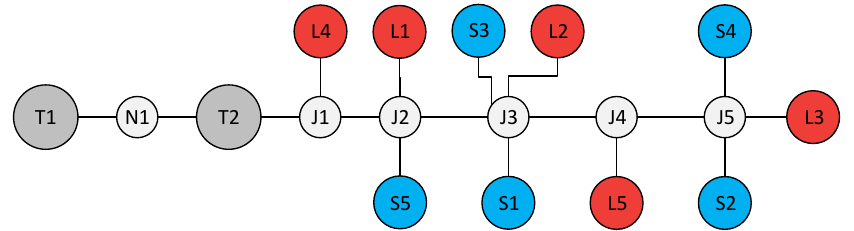
Figure 9. Graph model of single-line diagram under